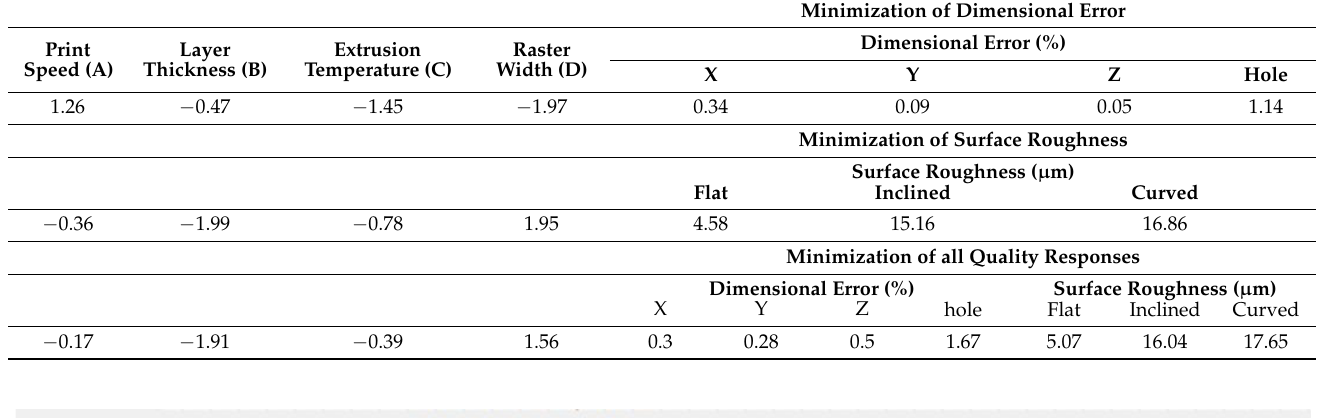
Table 6. Parameter settings for optimization of quality responses as recommended by the hybrid RSM and NSGA II approach.